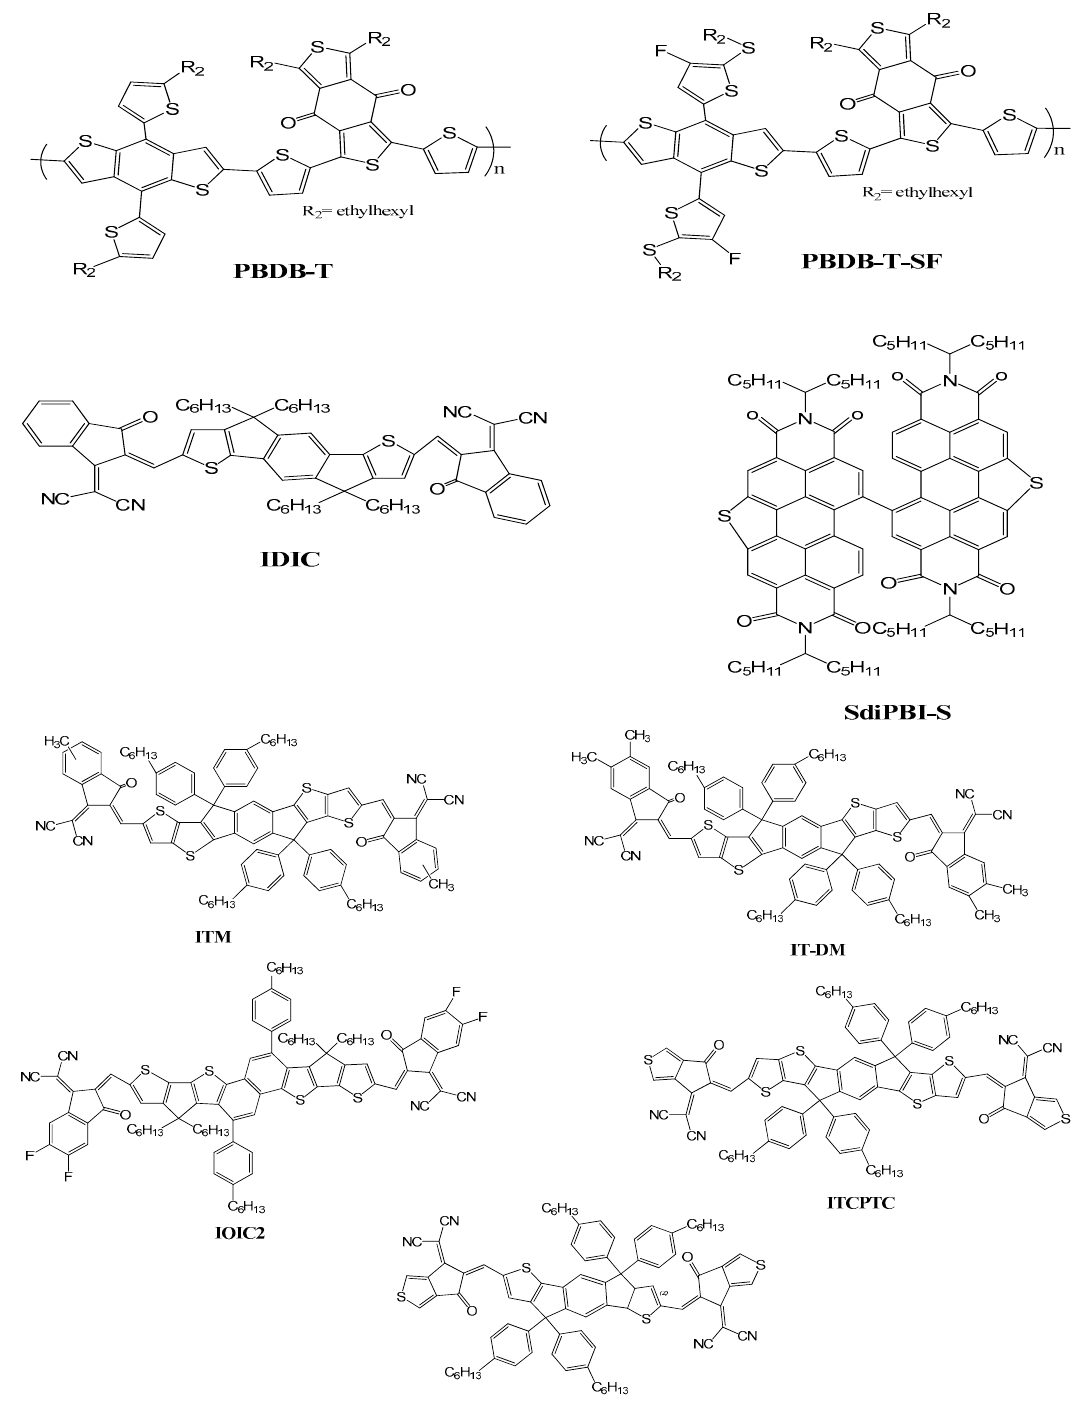
Figure 3. Common materials used in polymer photovoltaics. PCBM: (6,6)-phenyl-C61-butyric acid methyl ester; MDMO-PPV : poly(2-methoxy-5-(3’,7’-dimethyloctyloxy)-1,4-phenylene-vinylene); RR-P3HT: regioregular poly(3-hexylthiophene); PCPDTBT: poly[2,6-(4,4-bis-(2-ethylhexyl)-4H-cyclopenta[2,1-b;3,4-b]-dithiophene)-alt-4,7-(2,1,3-benzothiadiazole)]; PCDTBT: Poly[N-9 (cid:48) -heptadecanyl- 2,7-carbazole-alt-5,5-(4 (cid:48) ,7 (cid:48) -di-2-thienyl-2 (cid:48) ,1 (cid:48) ,3 (cid:48) -benzothiadiazole)]; PffBT4T-C9C13: Poly[(5,6-difluoro-2,1,3-